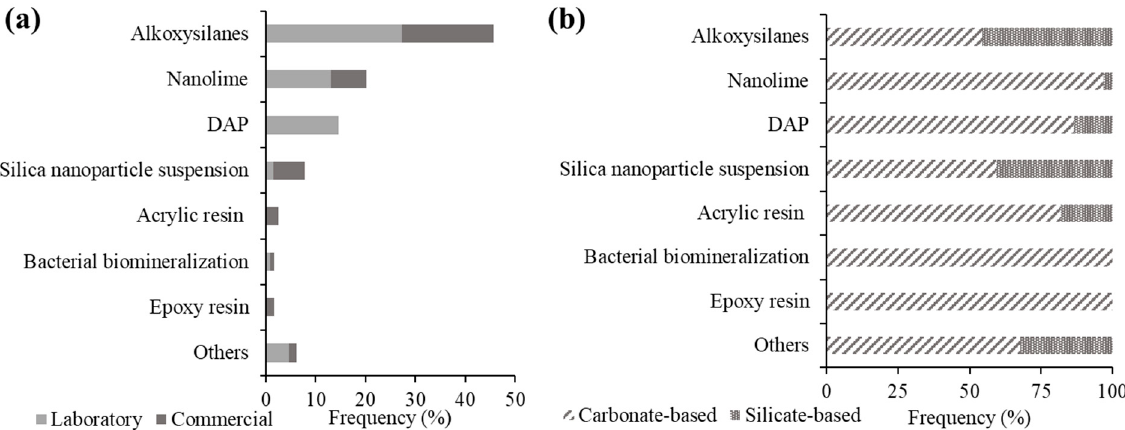
Figure 4. Distribution of the most used families of consolidants in stone consolidation research ( a ) and percentages according to the stone’s chemical nature ( b ).